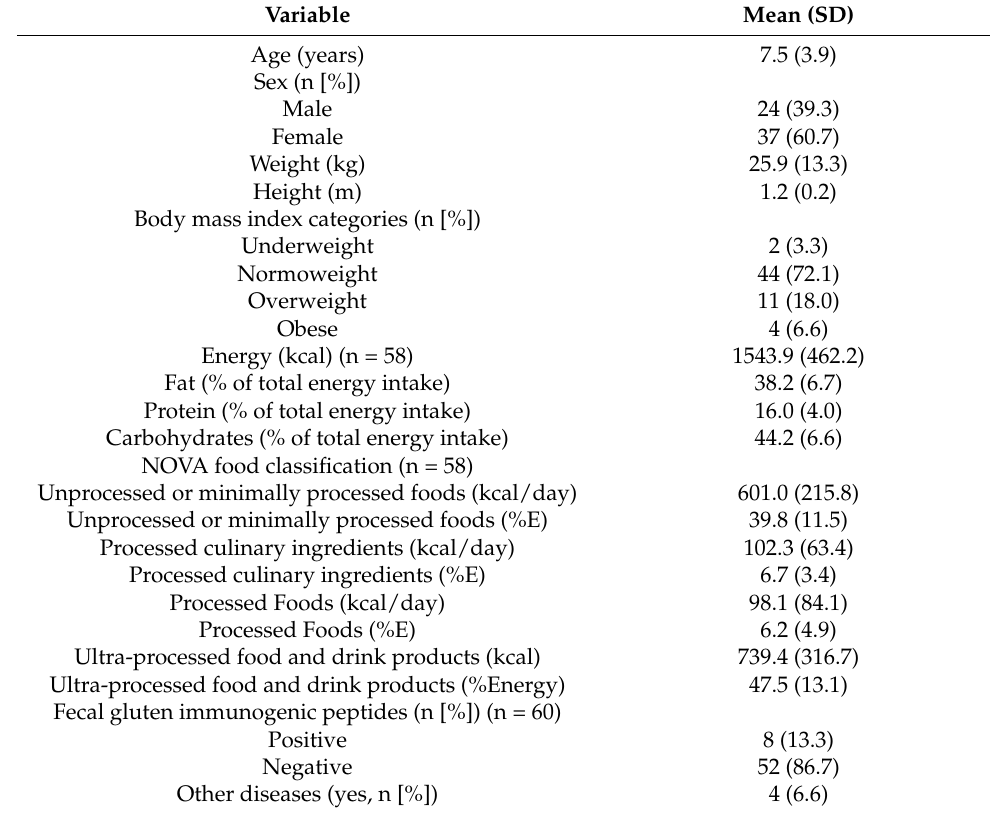
Table 1. Characteristics of the study participants (n =